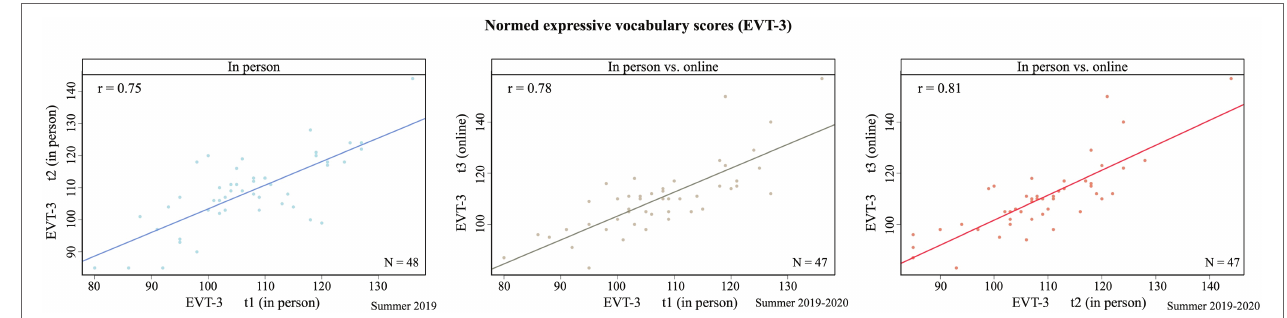
FIGURE 6 | Pearson correlation coefficients between in-person and online testing of a normed expressive vocabulary test (EVT-3), as described in the AV study (N = 47; Gijbels et al., in press). There is no significant difference between repeated in-person testing and in-person vs. online testing.